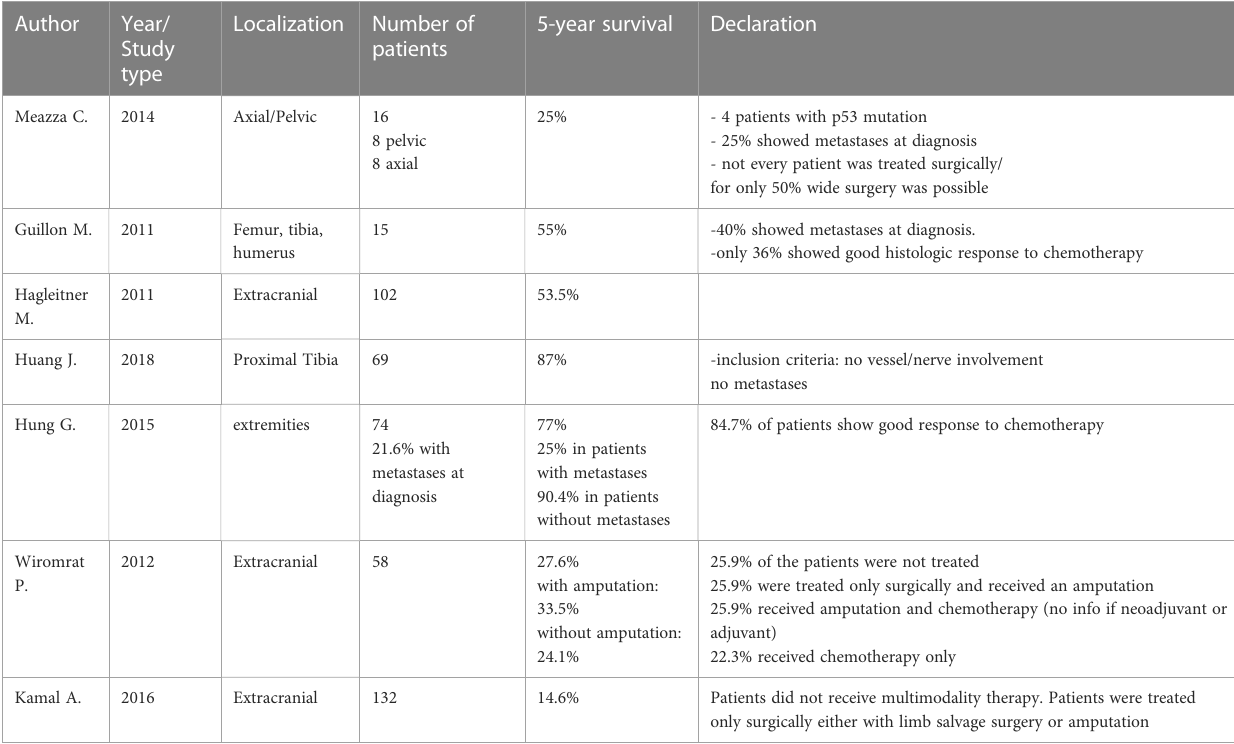
TABLE 2 5-year survival of EOS